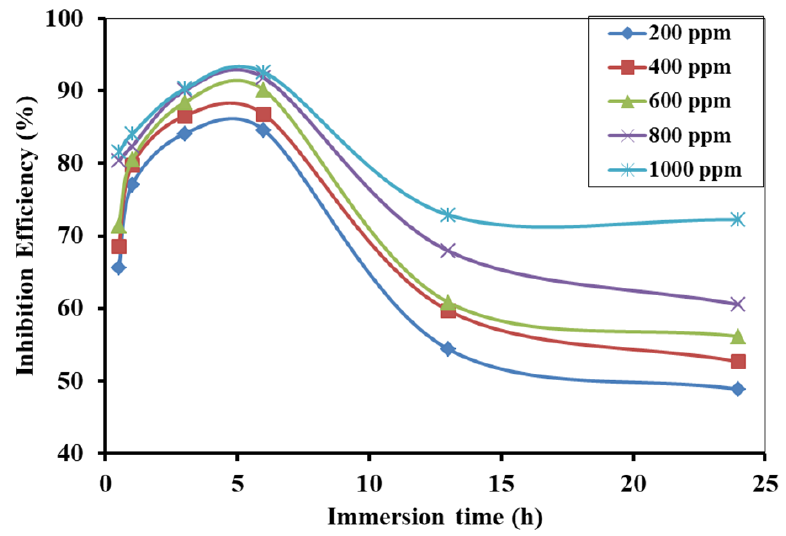
Figure 8. Inhibition efficiency of AV alkaloids for mild steel immersed at different intervals of time.